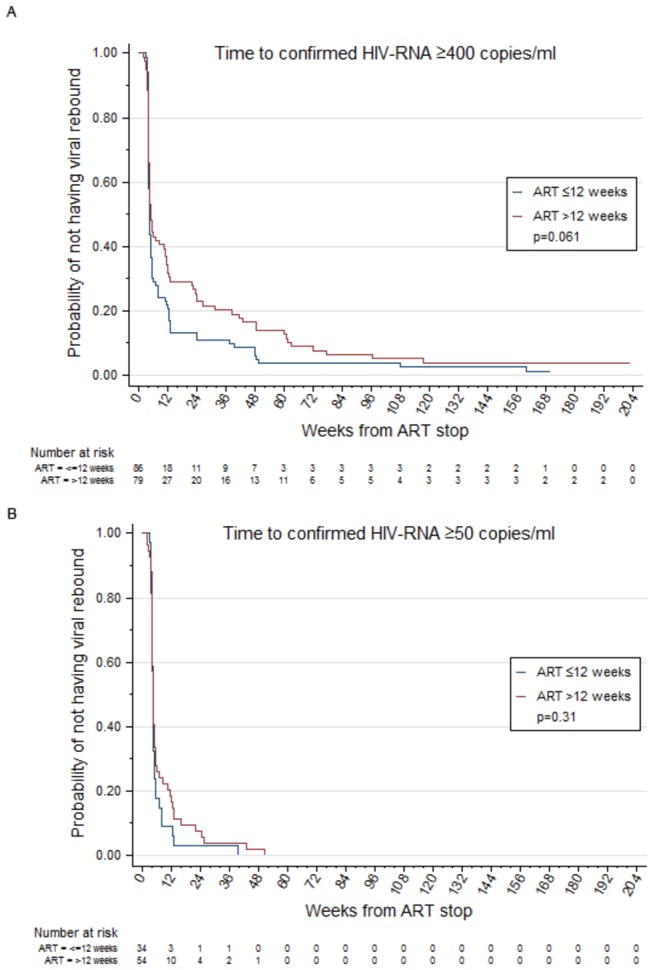
Time to confirmed plasma HIV-1 RNA detection by duration of ART.Kaplan Meier survival analysis showing time to virological rebound defined as (a.) <400 HIV-1 RNA copies/ml of plasma and, (b.) <50 RNA copies/ml of plasma. The x-axis shows weeks since cessation of ART. The y-axis shows proportions of participants remaining undetectable. Numbers at risk and contributing to the analysis at each time-point are shown below the x-axis. ART: antiretroviral therapy; VL = viral load.